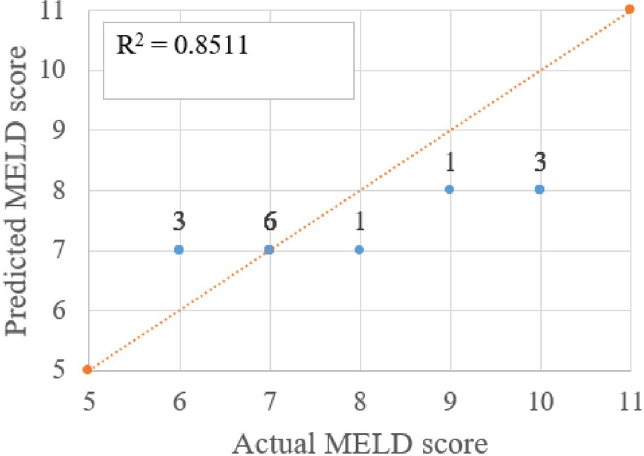
Figure 12. Comparison of actual and predicted MELD score (using ETR) and number of instances shown as